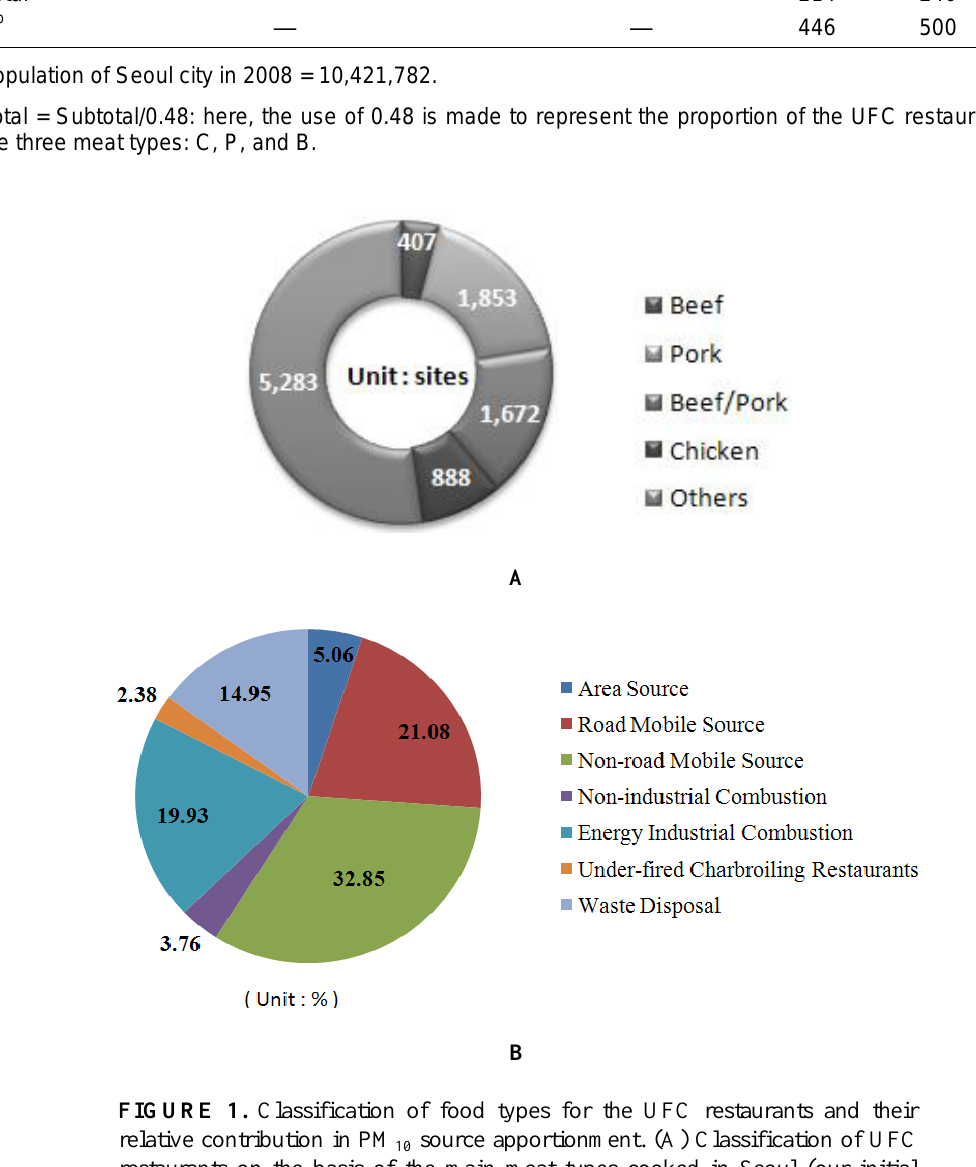
Emission Rates of PM